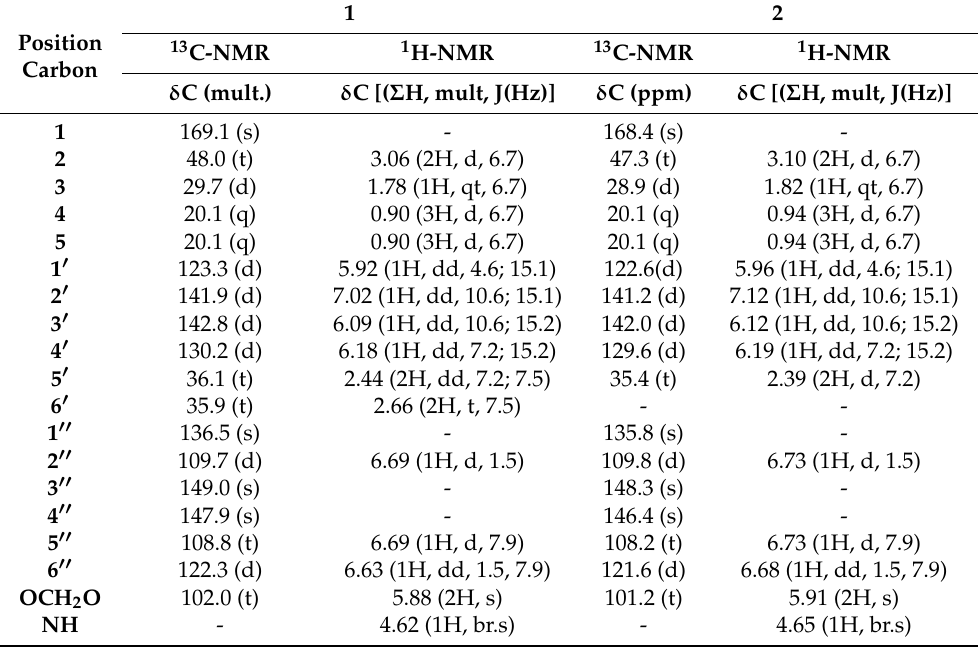
Figure 3. Selected HMBC and COSY correlations for piperenamide A-B ( 1 – 2 ). Table 3. NMR data compound 1 – 2 (500 MHz for 1 H dan 125 MHz for 13 C).